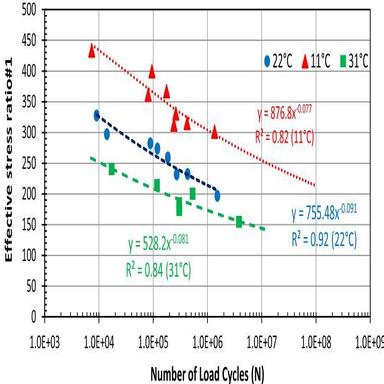
Effect of temperature on FBS flexural fatigue life (3% bitumen 2% lime FBS beam samples).